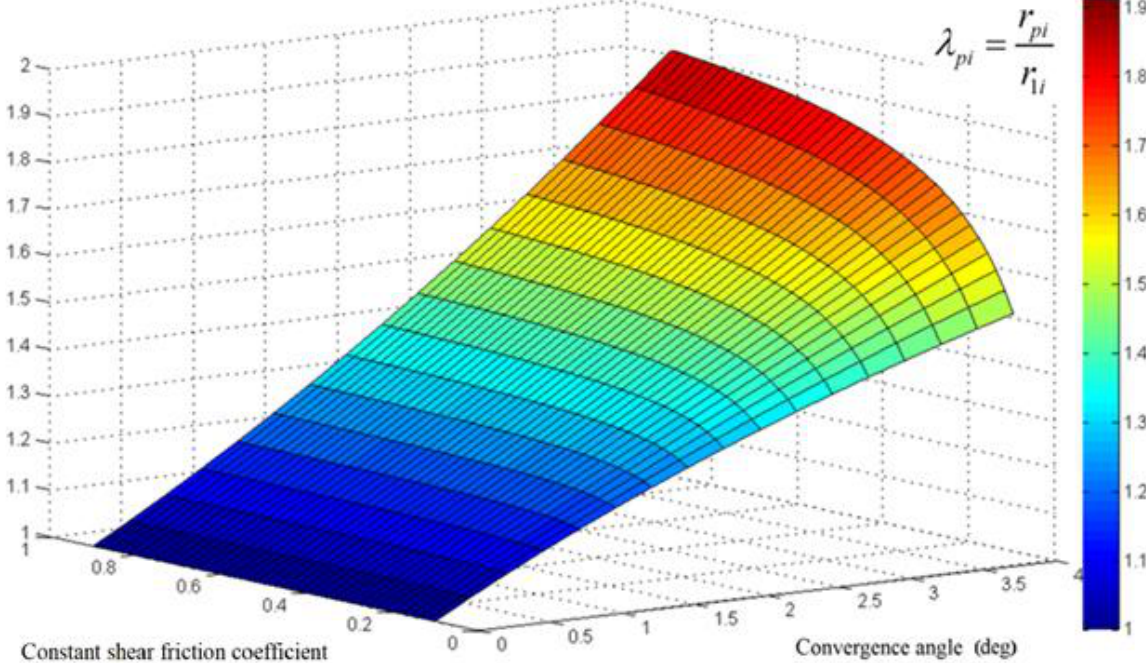
𝑟 𝑝𝑖 on the convergence angle (deg) of on the convergence angle (deg) of r 1 i 𝑟 1𝑖